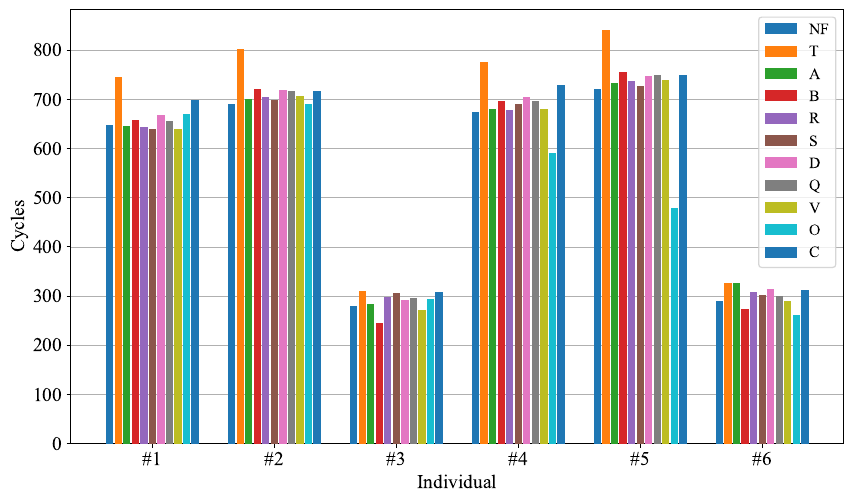
Figure 4. The number of samples of each individual and the number of samples of each